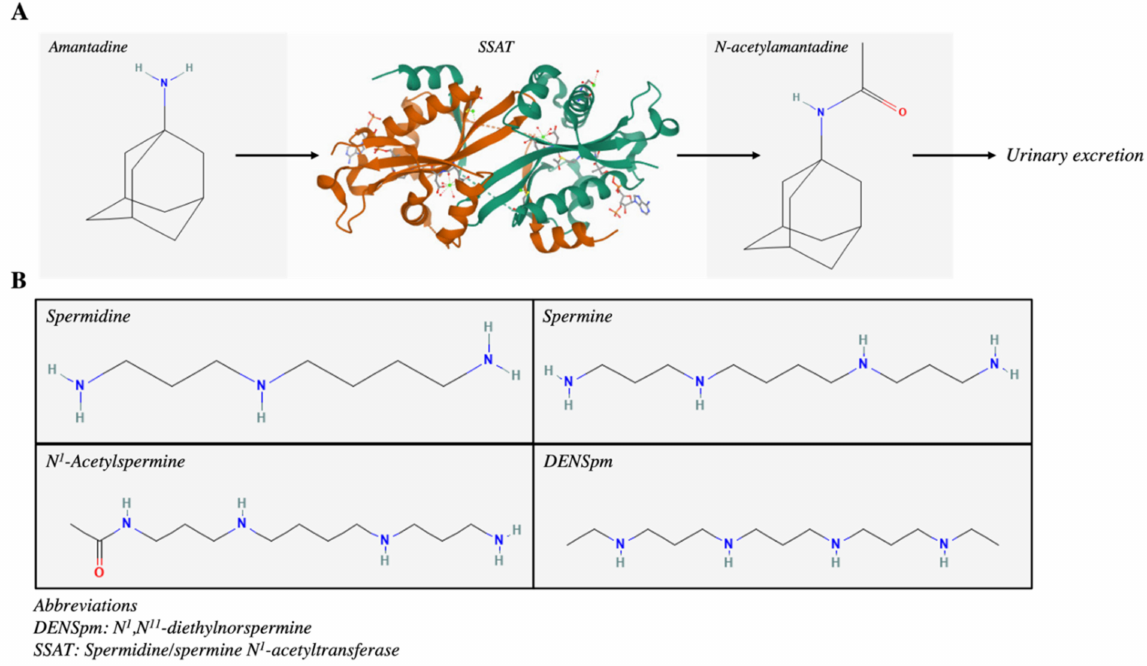
Figure 2. Therapeutic potential of SSAT as a biomarker and target of polyamine analogs. ( A ) Conver- sion of amantadine to N-acetylamantadine by SSAT, followed by urinary excretion. ( B ) Common targets of SSAT; DENSpm resembles the structure of other SSAT substrates and resulted in superin- duction of